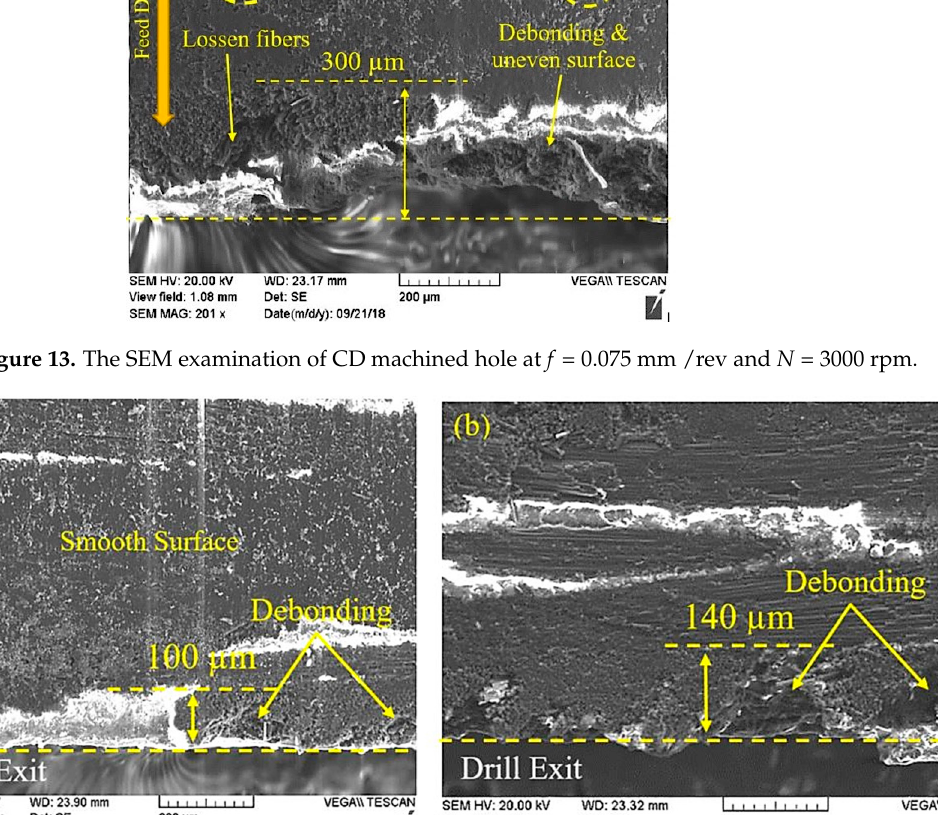
Figure 15. The SEM examination of HF-VAD machined hole at f = 0.075 mm/rev and N = 3000 rpm on the exit surface for ( a ) F = 1500 Hz and ( b ) F = 2150 Hz. 4.4.3. Surface Roughness Analysis of the surface roughness (Ra, Rz) at N = 2000 rpm indicated no significant difference between VAD and CD. For all machining conditions, the maximum Ra and Rz were 1.5 µm and 10 µm, respectively, for both machining techniques. However, increasing the cutting speed to N = 3000 rpm resulted in a higher Ra and Rz for CD (3 µm and 17 µm), while the maximum Ra and Rz for VAD were 1.5 µm and 10 µm, respectively. This reduction is attributed to the lower cutting temperature which enhances the matrix stiffness. Figure 16 shows the surface texture analysis for VAD and CD machined surfaces. The minimum depth was 6 µm for VAD and 14.5 µm for CD. This observation confirms the benefits of VAD regarding cutting temperature, as described in Section 4.2.